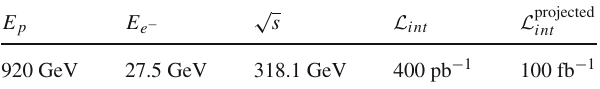
Table 5 Beam and centre of mass energies along with integrated lumi- nosities at HERA E